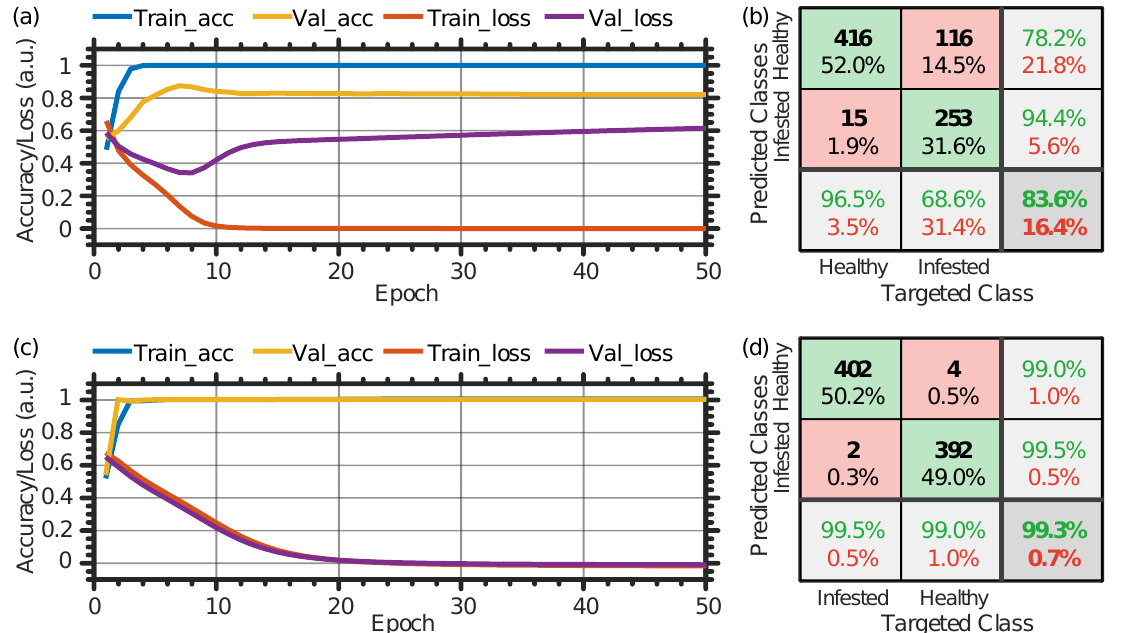
Figure 9. Training and validation history ( a / c ) and confusion matrix ( b / d ) when ignoring the wind and using the temporal/spectral dataset with the ANN. Train_acc: training accuracy; Val_acc: validation accuracy; Train_loss: training loss; Val_loss: validation